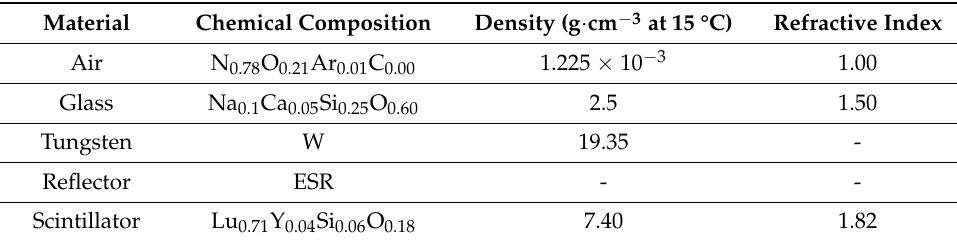
Table 2. Elementary properties of the